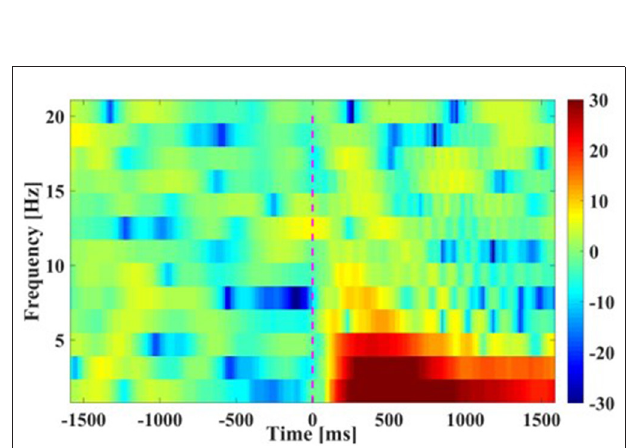
FIGURE 4 | The averaged MRCPs at electrode Cz during the time period [ − 1.5, 1.5] s of Go-Cue. “L” and “R” refer to the right-hand movement in right and left directions. Note that time 0s is the Go-Cue, and time 0.5s is the actual movement onset.